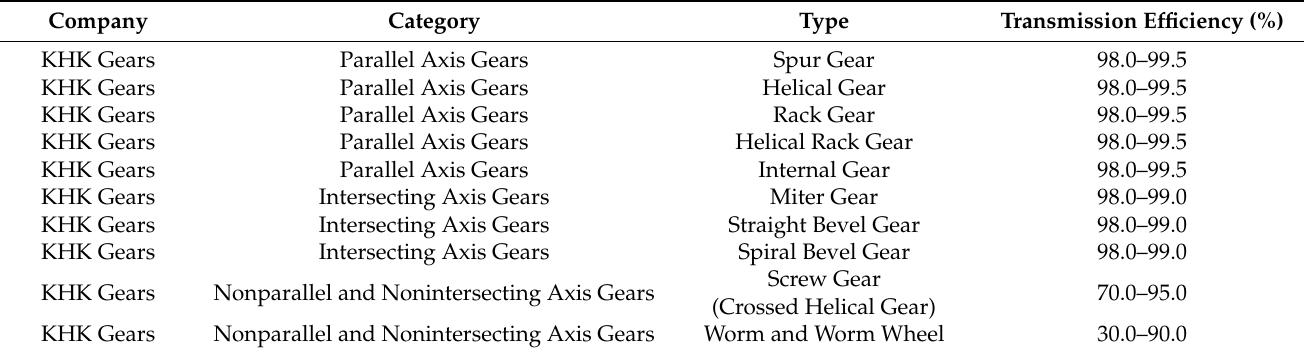
Table 2. Efficiency DB for each type of gear